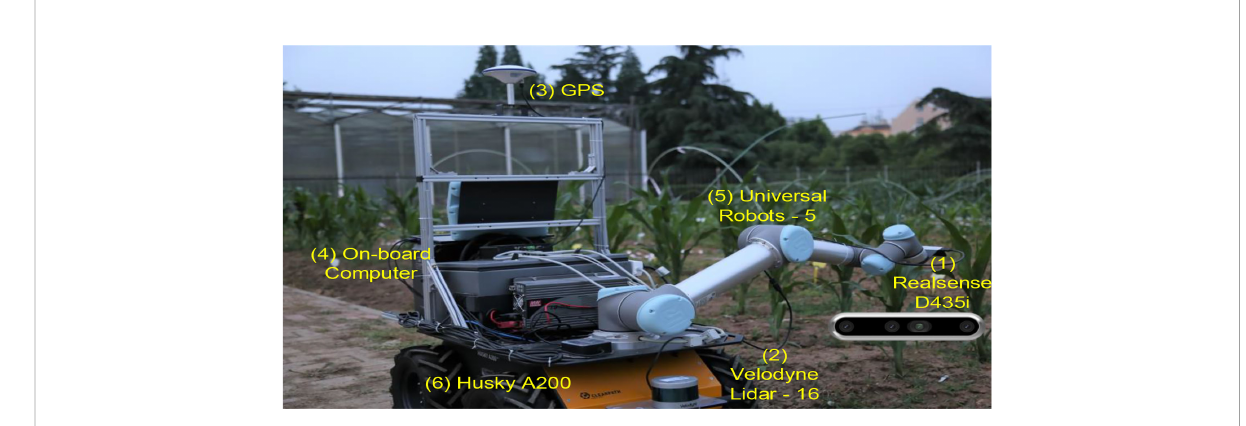
FIGURE 8 Our robot platform (capture pictures by (1) and run models on